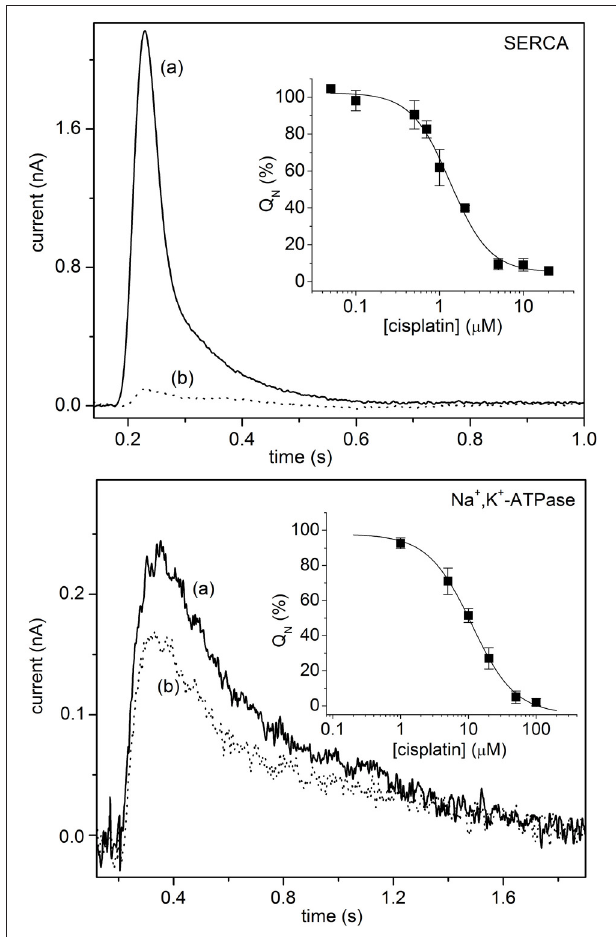
FIGURE 2 | Upper Panel: SERCA current signals induced by 100 µ M ATP concentration jumps in the presence of 10 µ M free Ca 2 + and in the absence (control measurement, solid line, a) or in the presence of 5 µ M cisplatin (dotted line, b). ( Inset ) Normalized charges (Q N ) related to ATP concentration jumps in the presence of Ca 2 + ions as a function of cisplatin concentration. The charges are normalized with reference to the maximum charge attained in the absence of cisplatin (control measurement). The solid line represents the fitting curve to the ATP-induced charges (IC 50 = 1.3 ± 0.1 µ M). The error bars represent S.E. of three independent measurements. Lower Panel: Na + ,K + -ATPase current signals induced by 100 µ M ATP concentration jumps in the presence of 80mM NaCl and 50mM KCl, and in the absence (control measurement, solid line, a) or in the presence of 5 µ M cisplatin (dotted line, b). ( Inset ) Normalized charges (Q N ) related to ATP concentration jumps in the presence of Na + and K + ions as a function of cisplatin concentration. The charges are normalized with respect to the maximum charge measured in the absence of cisplatin (control measurement). The solid line represents the fitting curve to the ATP-induced charges (IC 50 = 11.1 ± 0.8 µ M). The error bars represent S.E. of three independent measurements. Tadini-Buoninsegni et al. (2017)—Reproduced by permission of The Royal Society of